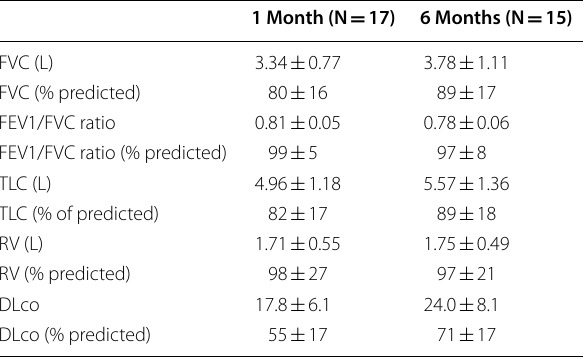
All data are presented as mean